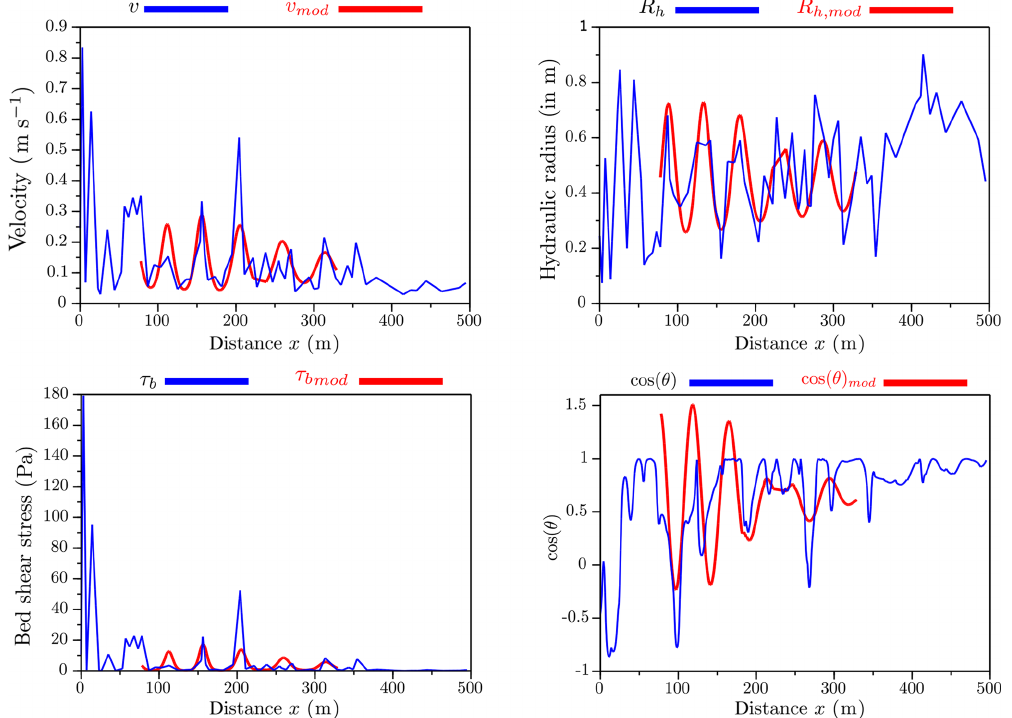
Figure 8. Variation of the modeled function f i, mod , which represents the pseudo-periodic variable (in red) for the velocity, the hydraulic radius, the bed shear stress, and the local channel direction angle of the Olivet River compared to the observed ones (in